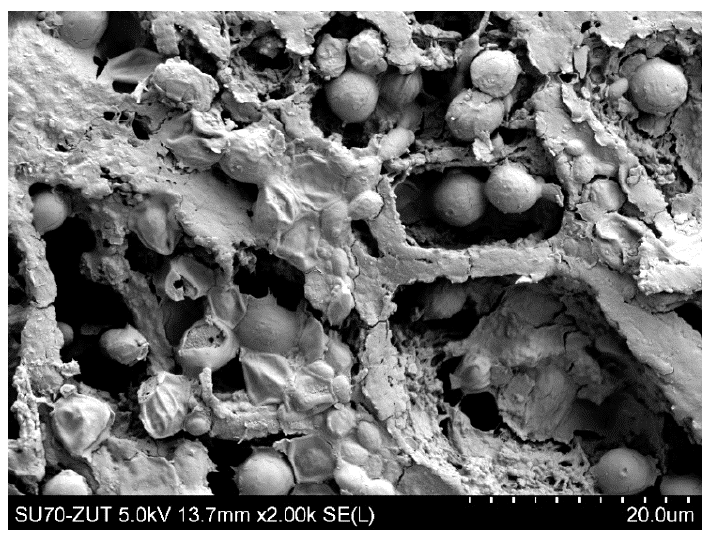
Figure 19. SEM image of PP S6/2 membrane (module M3) surface covered by biological deposit with yeast cells after MF process of yeast suspensions.